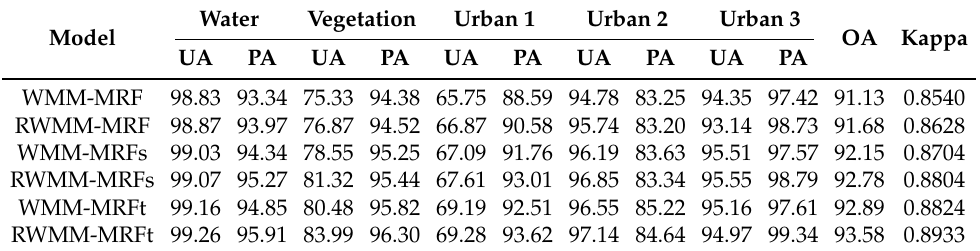
Table 6. Classification Accuracy (%) of Six Different Algorithms on the Boao